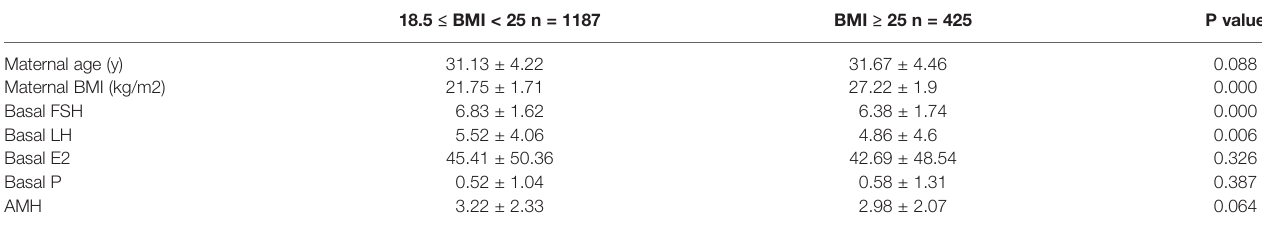
TABLE 1 | Female clinical basic characteristics in group 1 and group